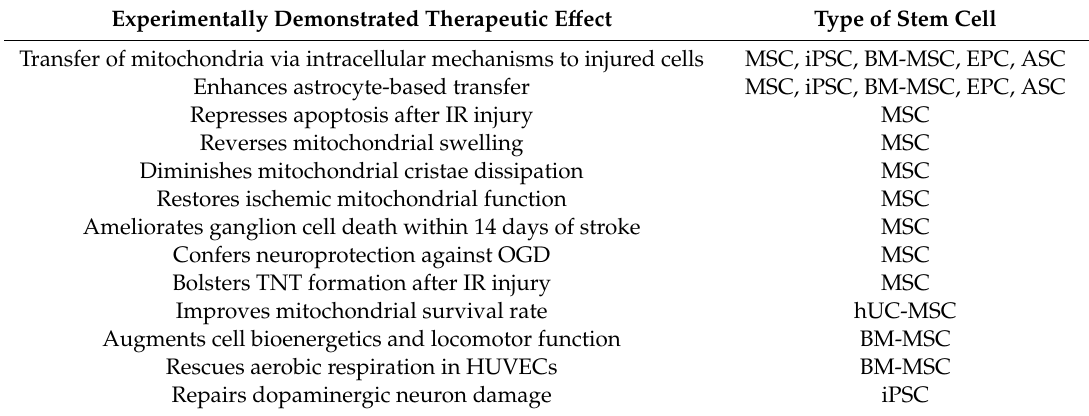
Table 2. Overview of Stem Cell-Mediated Mitochondrial Repair for